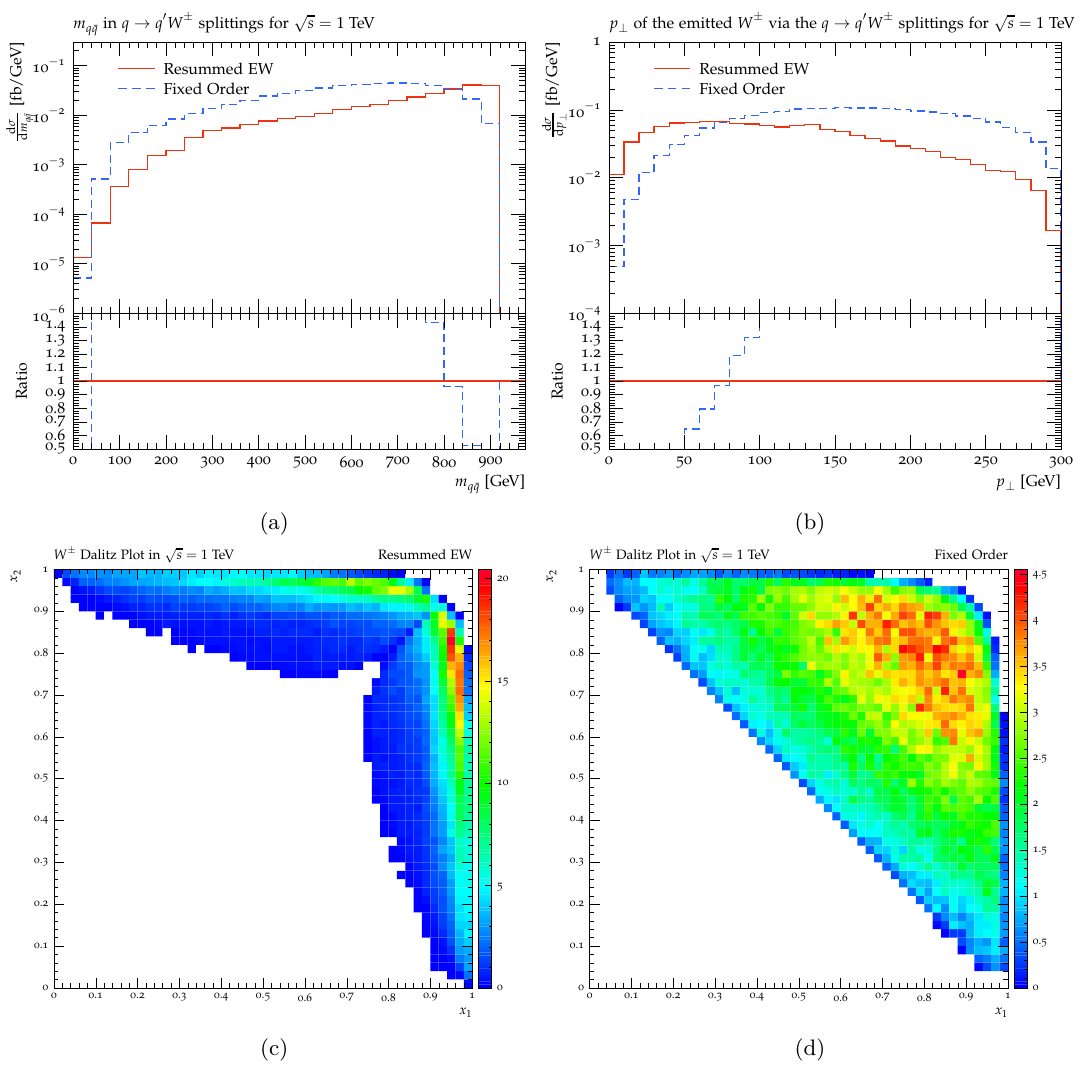
Figure 2. Performance test for q → q 0 W ± EW branching in Herwig 7 for and (b) show the differential rate of W ± emissions respectively as functions of the mass of the quark-antiquark system, m q ¯ q and the transverse momenta of radiated gauge bosons in the Sudakov parametrization, p ⊥ . (c) and (d) illustrate the differential rate of W ± emissions as functions of the light-cone fraction of the momentum of the quark-antiquark pairs, x 1 and x 2 , in resummed EW and FO calculations,